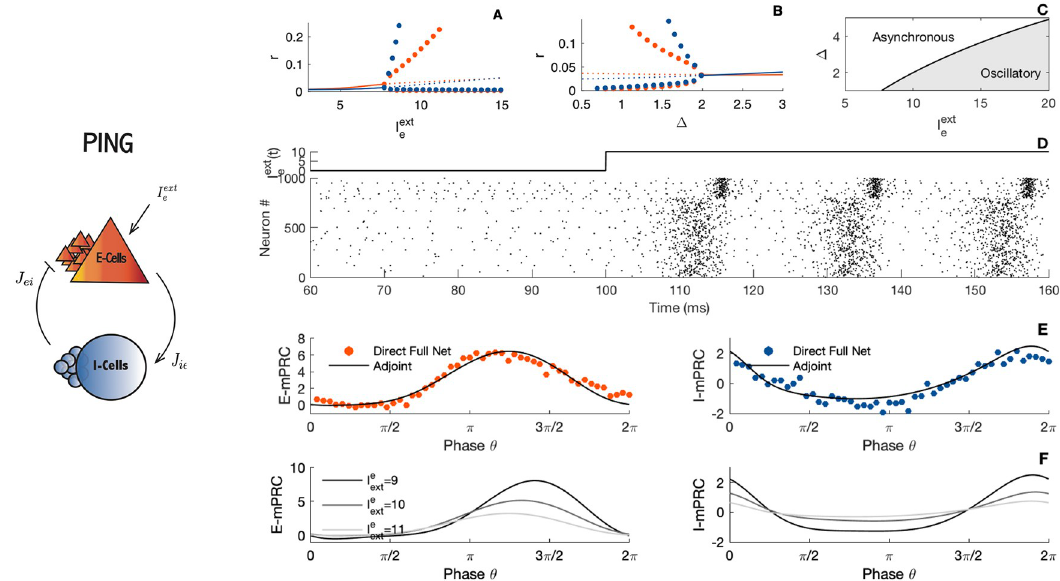
Fig 2. The PING interaction. Left panel: A schematic illustration of the PING (Pyramidal Interneuron Network Gamma) interaction. The parameters are as in Fig 1. Right panels: Nonlinear analysis of the PING rhythm. A-B) Bifurcation diagrams. The blue line, (respectively the red line), corresponds to the steady state of the inhibitory cells, (respectively the excitatory cells) while dots correspond to limit cycles. C) Stability region. D) The stimulus and corresponding raster plot of the spiking activity. E) Comparison between simulated and calculated mPRCs. The black line illustrates the analytical adjoint method while dots indicates direct perturbations of the full network. Red dots, perturbations are made on the E-cells, second row, with the blue dots, perturbations are made on the I-cells. F) PRC shape as a function of parameters obtained via the adjoint method for different values of the external current. Parameters: N e = N i = 5000; τ e = τ i = 10; τ se = τ si = 1; � Z ¼ � Z ¼ (cid:0) 5 ; J ee = 0; J ei = 15; J ii = 0; J ie = 15; I ext ¼ 0 ; v th = 500; v r = e i i ¼ 10 ; panel D) Δ = Δ = 1; panel E-F) Δ = Δ = 1; I e ¼ 10 , direct perturbations are made − 500; panel A) Δ e = Δ i = 1; panel B) I e e i e i ext ext with a square wave current pulse (amplitude 5, duration 0.5).